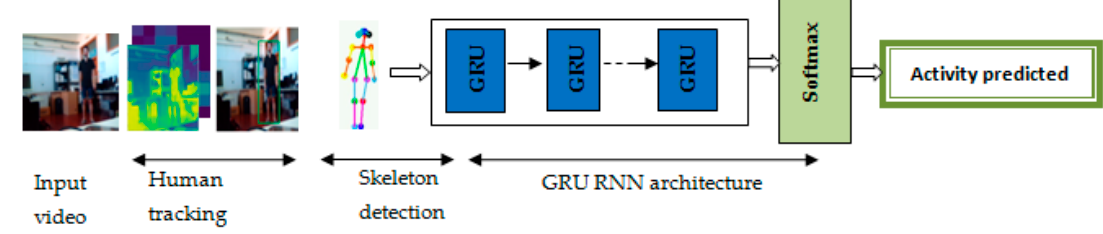
Figure 4. The structure of our human activity recognition system.